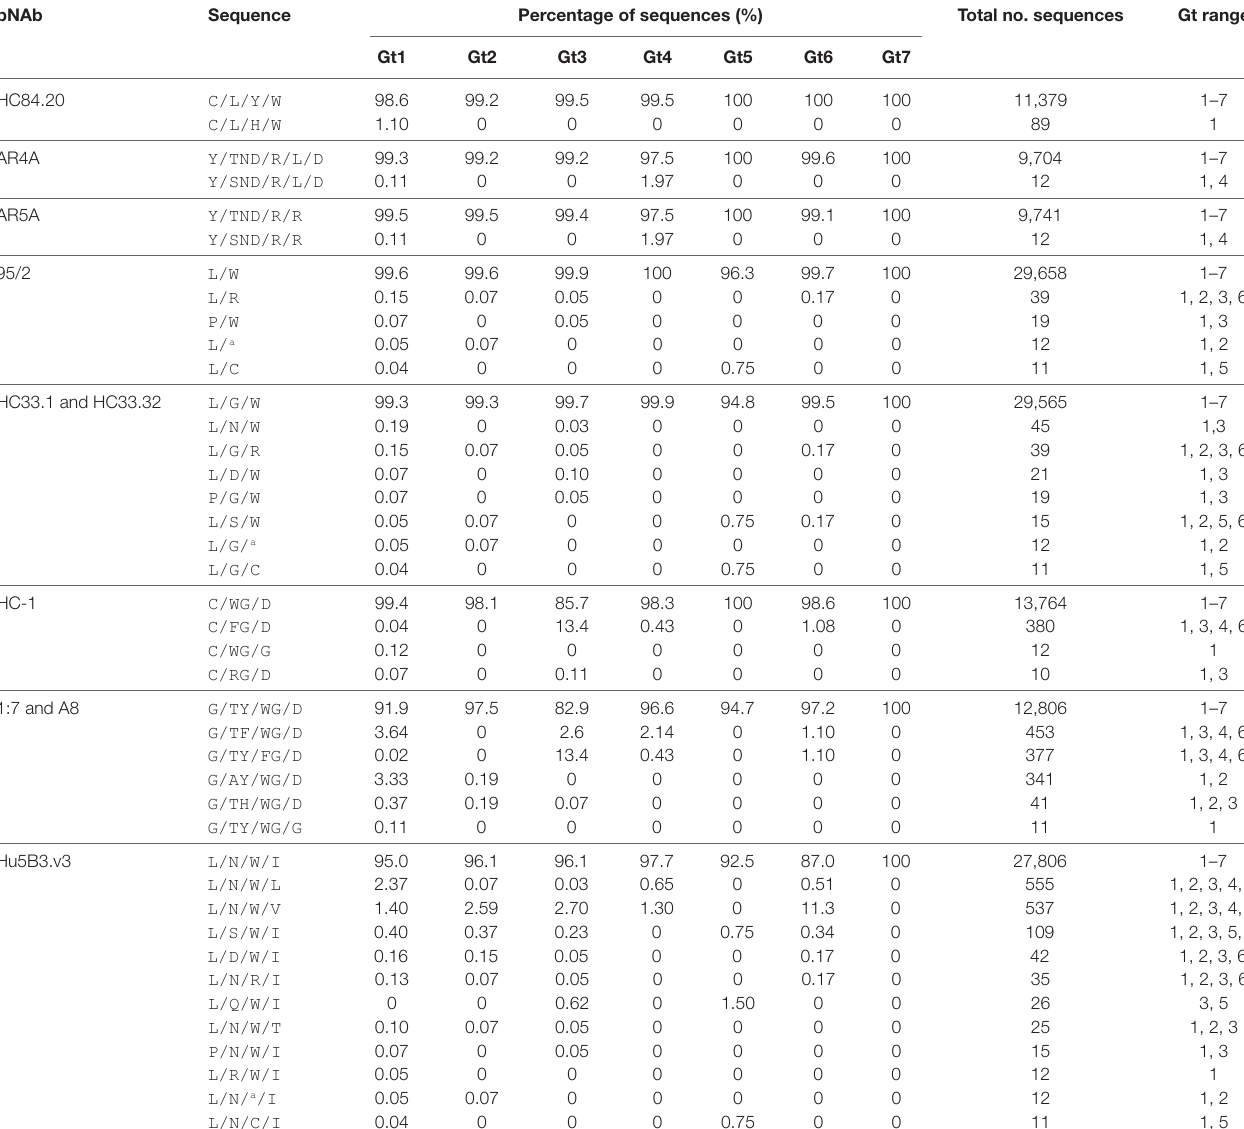
TaBle 4 | The most prevalent sequences for the complete bNAb epitope motifs. bnab